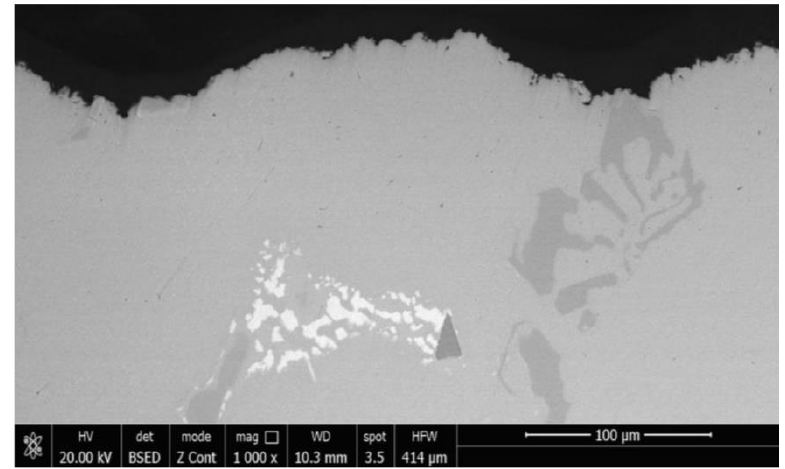
Figure 13. SEM microscopy of an unetched section through the surface of the reference samples (annealed).